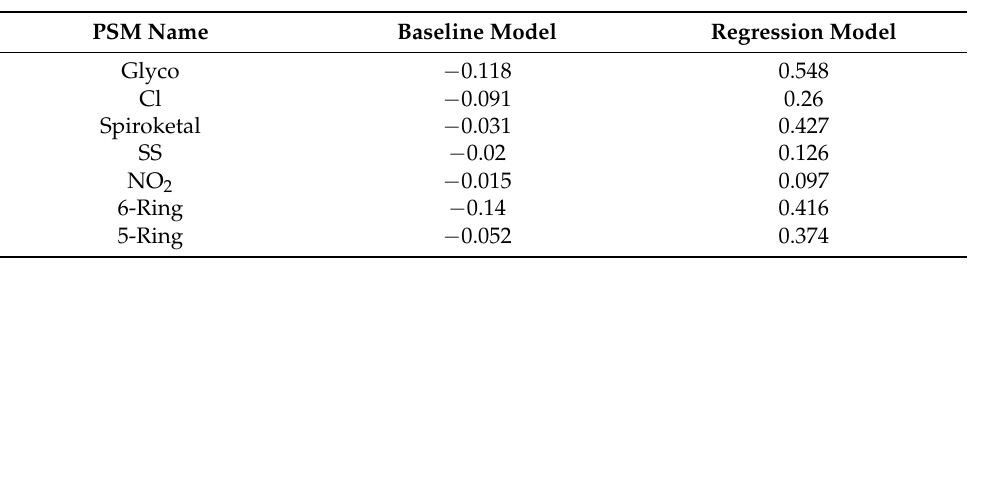
Table 8. R 2 -score (coefficient of determination) for the prediction of PSMs based on 5-fold cross- validation. The baseline is based on a hypothetical model, assuming that no PSM is predicted at